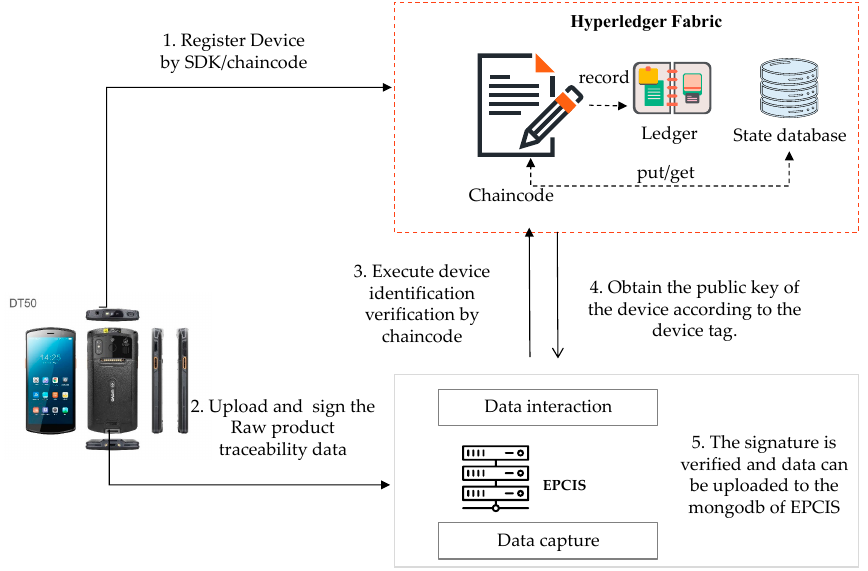
Figure 10. The process of collecting reliable data sources with an IoT